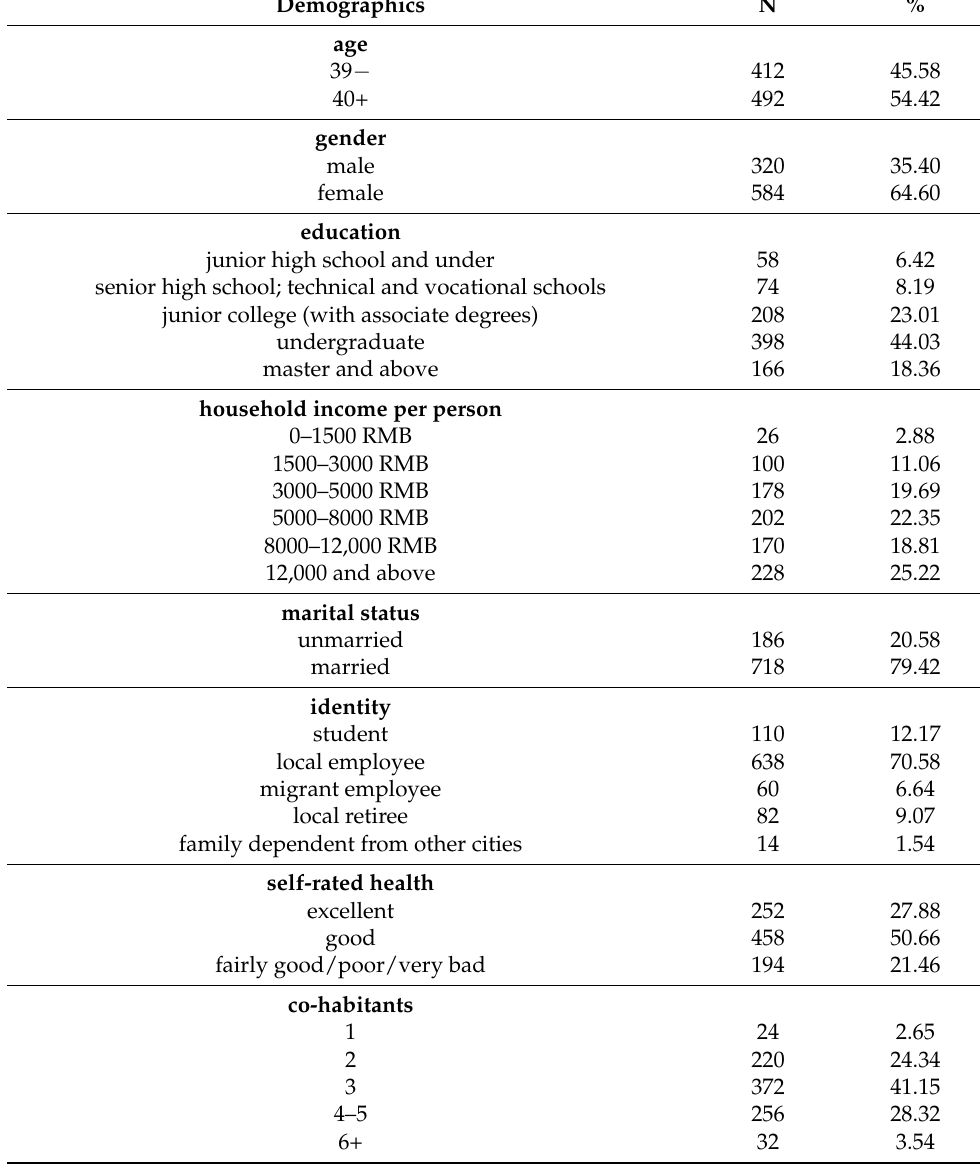
Table 1. The sample